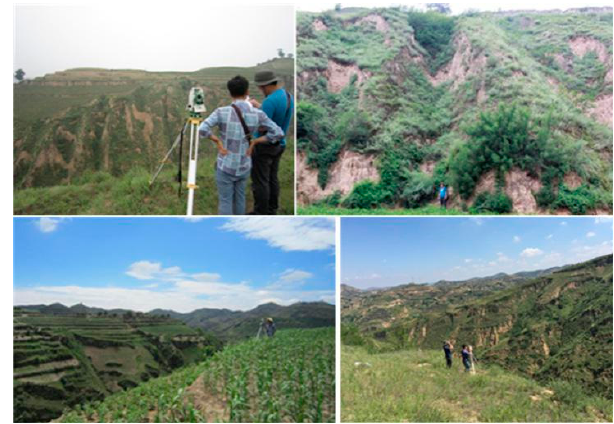
Figure 3. Field survey. Bank gully heads were measured by GNSS and total station in the study